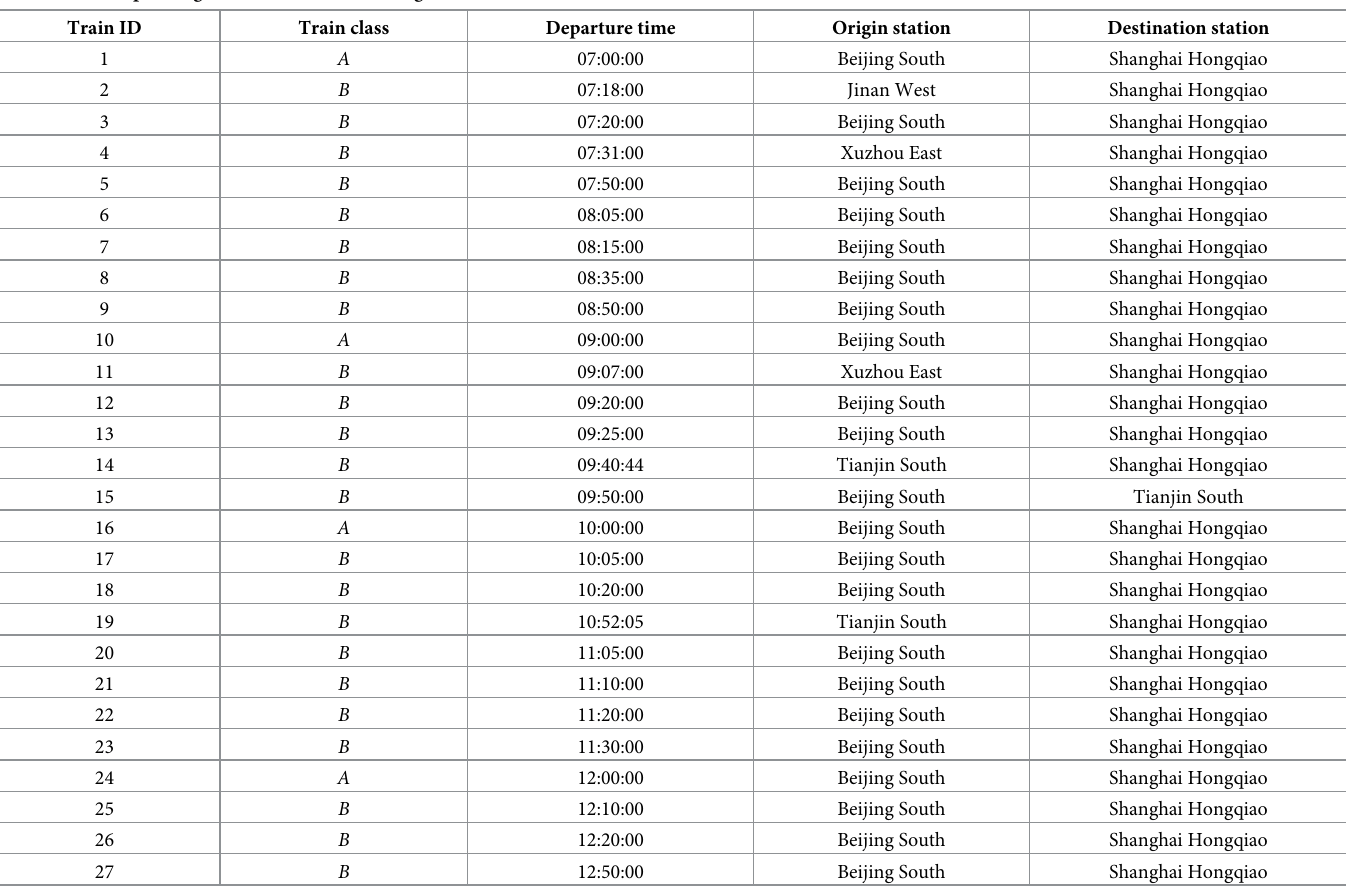
Table 5. Train operating information from the original timetable.